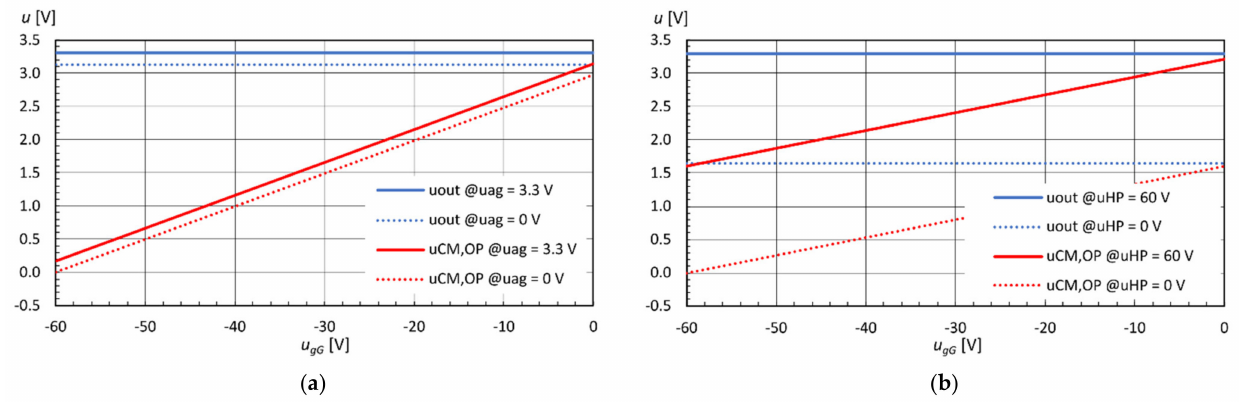
Figure 8. Single-stage circuit output u out and u CM , OP vs. u gG for limit input values for measurement of: ( a ) u ag ; ( b ) u HP .